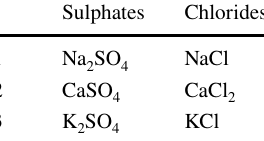
Table 5 Composition of brine formulations used in the experiments